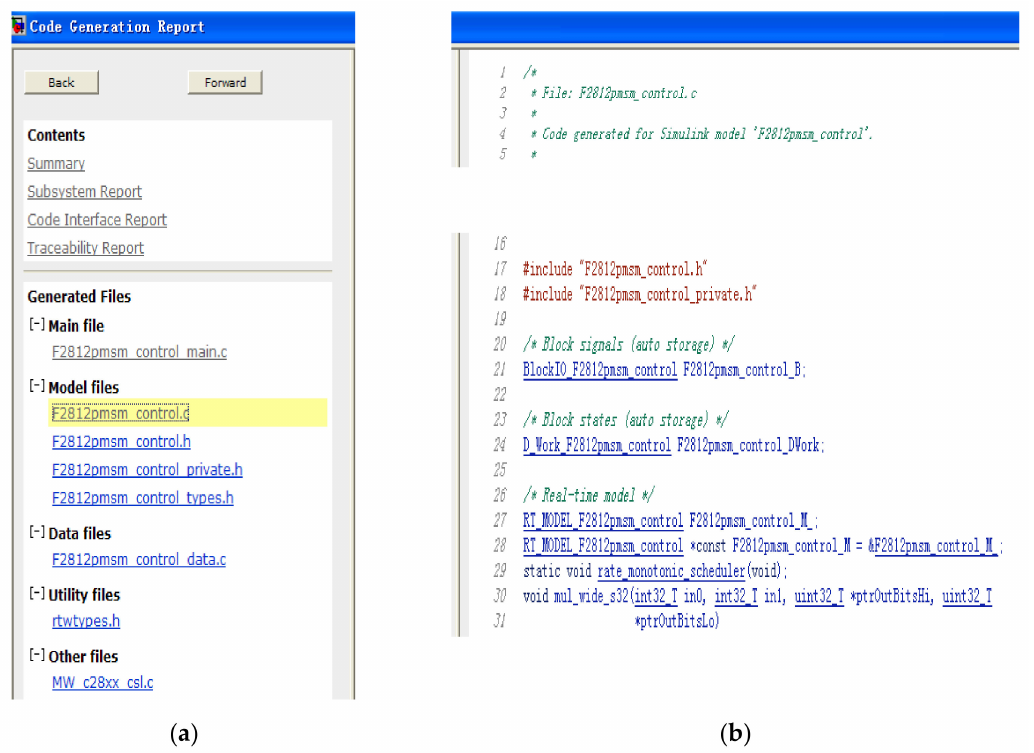
Figure 7. Code generation report and its generated files. ( a ) code generation report; ( b ) generated C file.